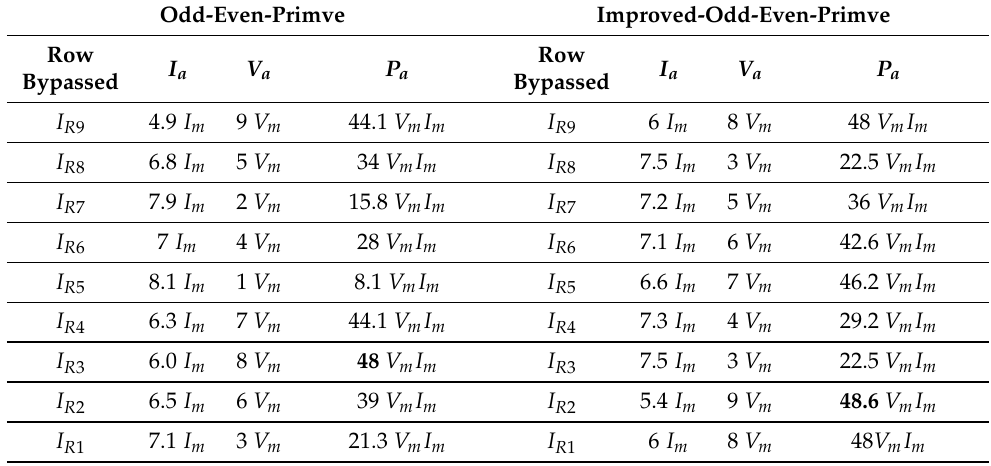
Table 6. GMPP for Group-V PSC.